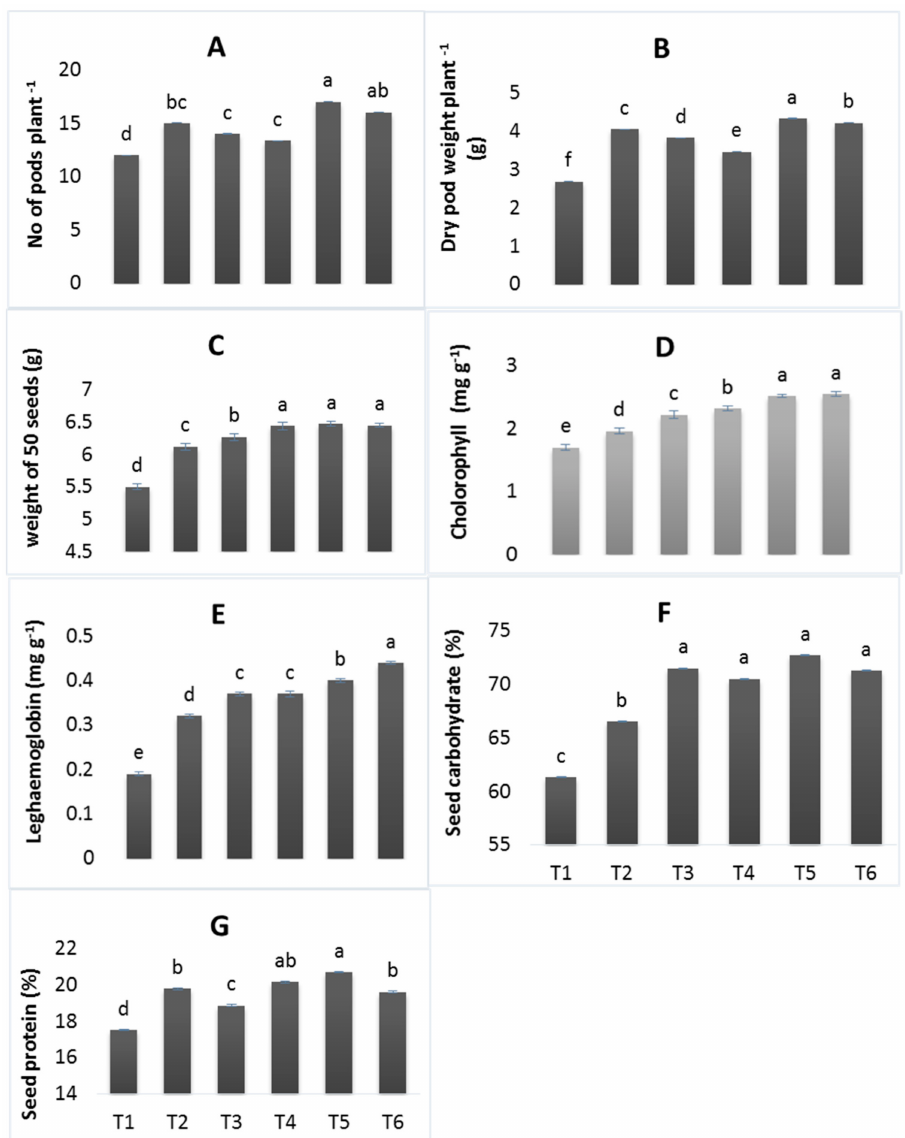
Figure 2. Effect of plant growth hormone and Rhizobium sp. On some yield ( A – D ) and quality ( E – G ) parameters of chickpea. T1: untreated control, T2: Rhizobium sp. Inoculation, T3: GA3 (10 − 4 M), T4: GA3 (10 − 5 M), T5: Rhizobium + GA3 (10 − 4 M), T6: Rhizobium +GA3 (10 − 5 M). Quantities sharing similar letters are not statistically different from each other at p >